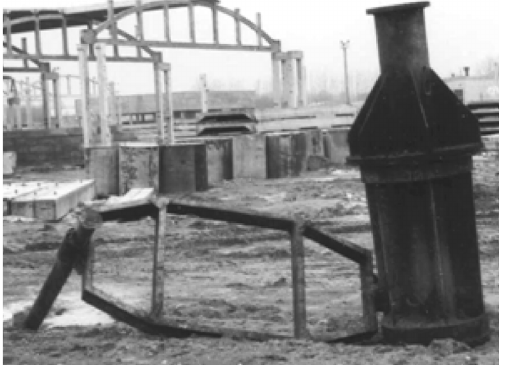
Fig. 3. The punch for ring driving